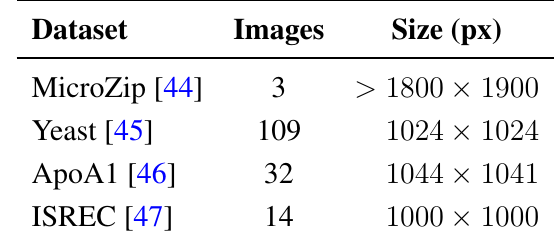
Table 2. Image sets referenced in the literature. All images are 16